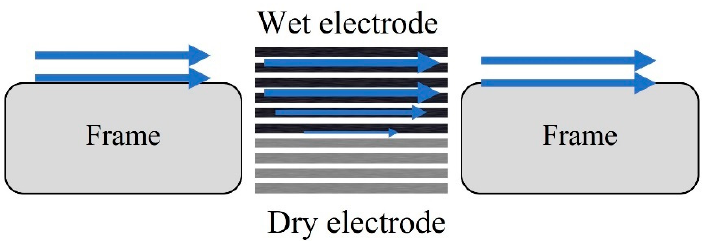
Figure 12. The schematic of electrolyte diffusing into electrode layers in a horizontal flow battery.